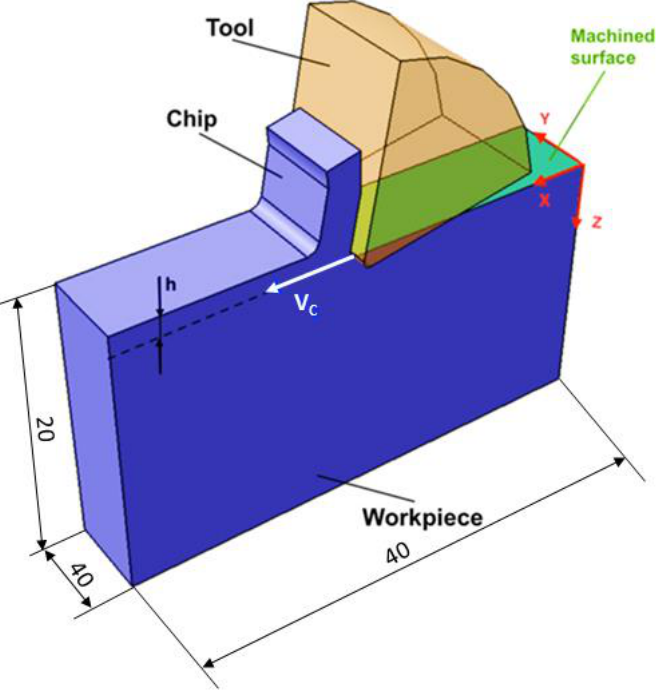
Figure 1. Schematic representation of the orthogonal cutting tests. Table 2. Tool geometry and cutting regime parameters used in orthogonal cutting tests.